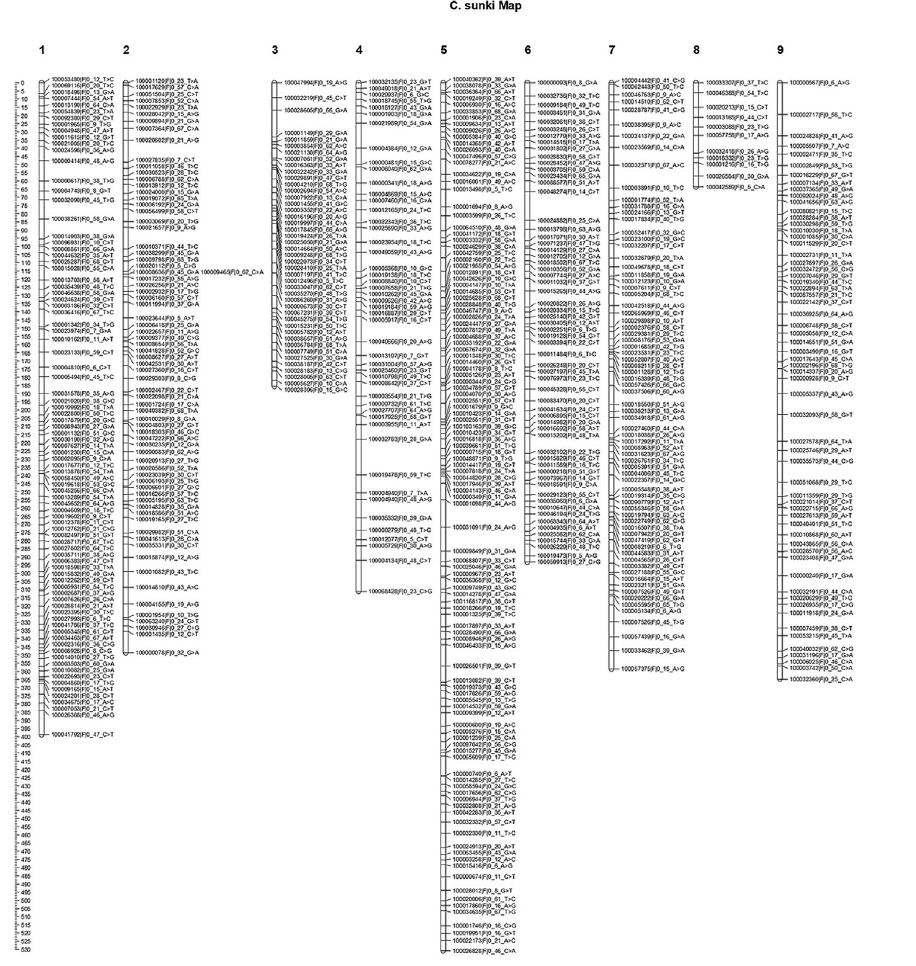
Figure 3 - Linkage map of C. sunki using the pseudo-testcross strategy. Distribution of the 571 SNP markers on nine linkage groups of the C. sunki link- age map. X-axis represents linkage groups, and Y-axis indicates the genetic location